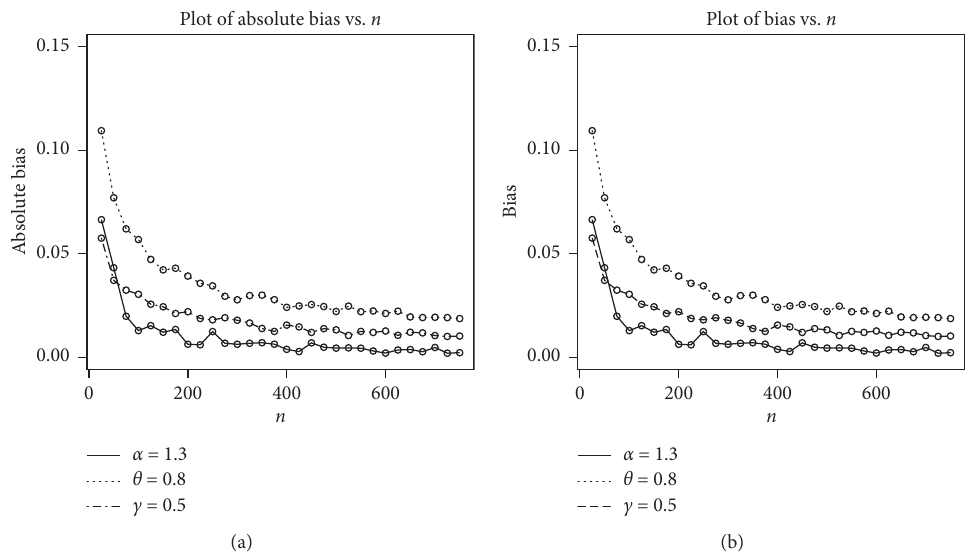
Figure 6: Biases and absolute biases plots of the NGE-Weibull distribution for α � 1 . 3, θ � 0 . 8, and c � 0 .